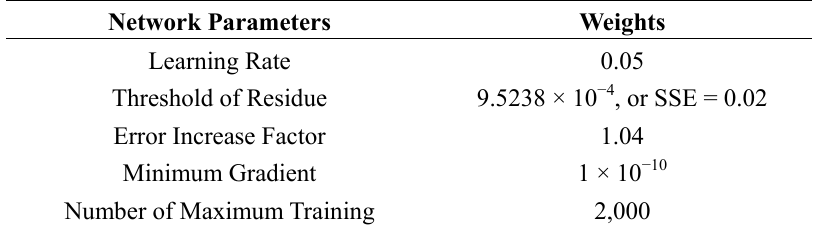
4. The Weights of the Artificial Neural Network (ANN) Parameters (Levenberg-Marquardt